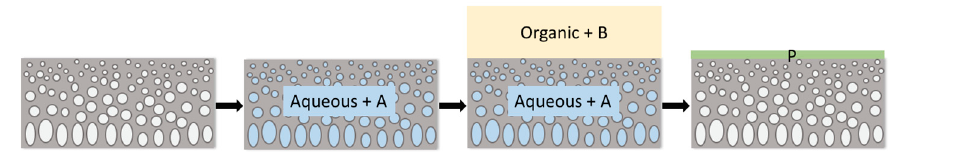
Figure 1. Schematic representation of the interfacial polymerization technique. A and B are monomers and P is the polymer formed at the interface. (adapted from [1]).